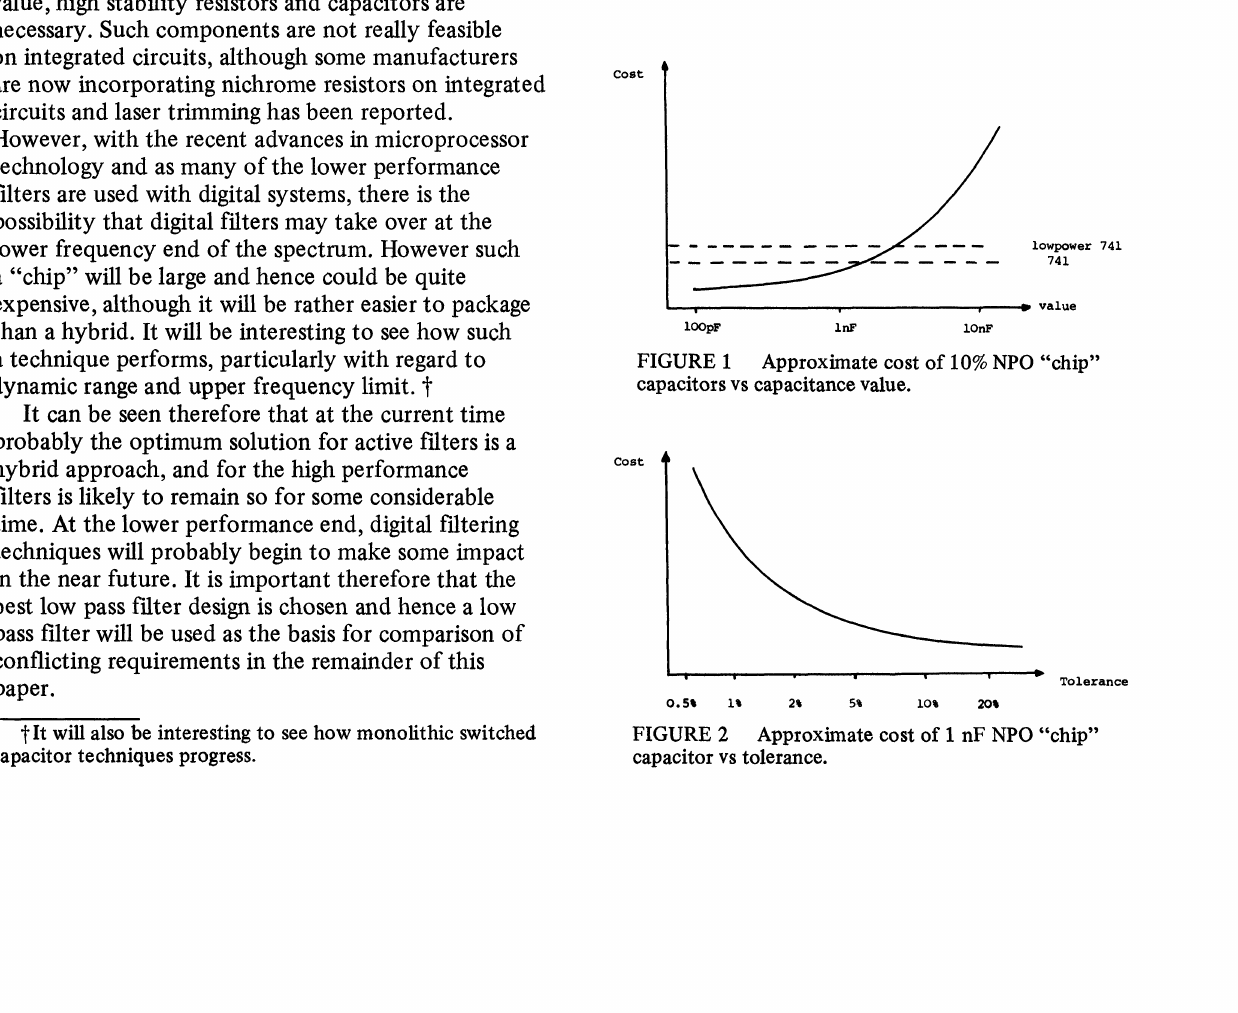
FIGURE 2 Approximate cost of 1 nF NPO "chip" capacitor vs tolerance.